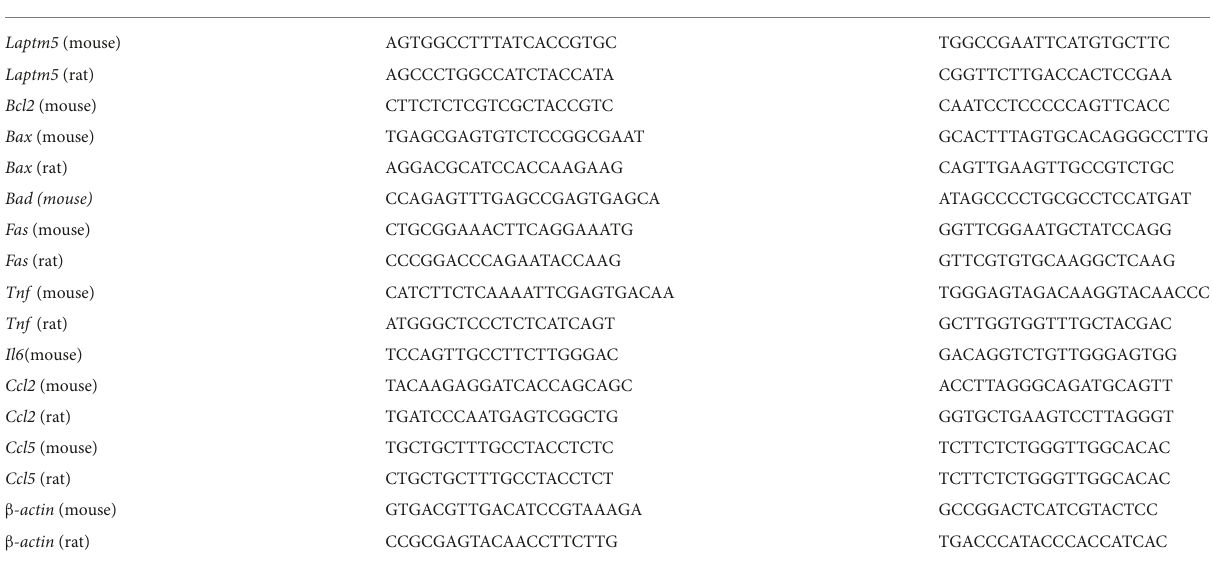
TABLE 2 Primer sequences for